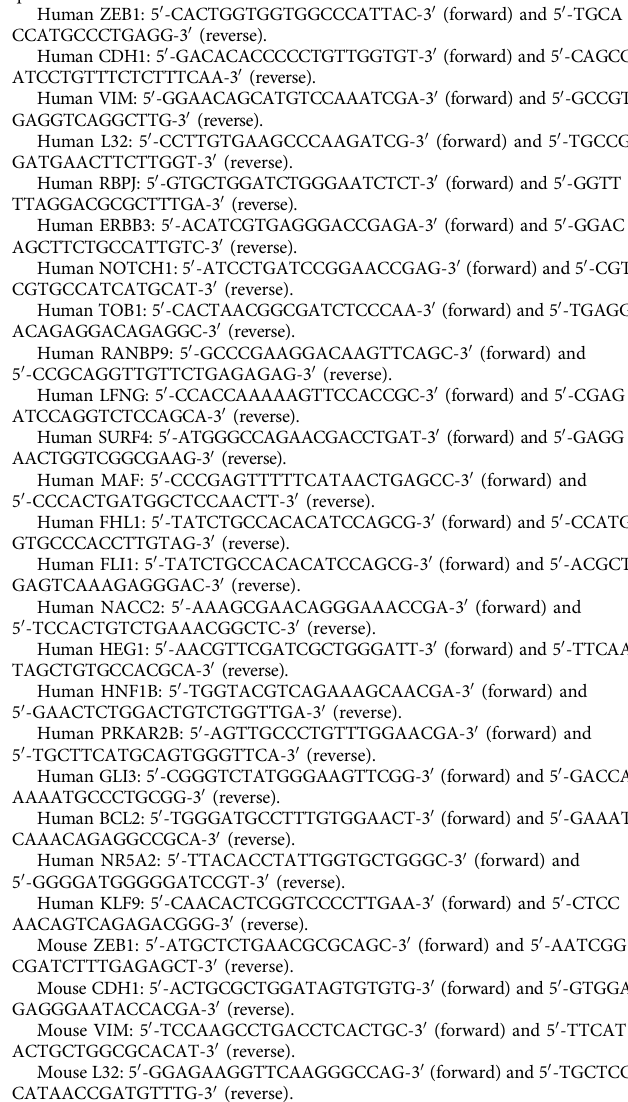
and 5 0 -TTGCGGCCGCGCTGCAAAGAGCACCTTT-3 0 (reverse); miR-200c- binding site mutant LFNG 3 0 -UTR: 5 0 -CTTTTTTTACTGTGCTGTTTTTTTTG-3 0 (forward) and 5 0 -GGTGTCACAATATTTACAGACACG-3 0 (reverse). NOTCH1 3 0 -UTR: 5 0 -GCTCTAGAGCCGACCAGAGGAGCCTTTT-3 0 (forward) and 5 0 -TTGCGGCCGCAACATCTTGGGACGCATCTGG-3 0 (reverse); miR-200c-binding site mutant NOTCH1 3 0 -UTR: 5 0 -CTTATGTAGTTGTTCGT TGGTTATAC-3 0 (forward) and 5 0 -GGTGAACCTGAAACAAAGATTCATG-3 0 (reverse). BCL2 3 0 -UTR: 5 0 -GCTCTAGAGCCACTGAGGAGCTTTGTTT-3 0 (forward) and 5 0 -TTGCGGCCGCGGCCTCTCTTGCGGAGTATT-3 0 (reverse). FHL 3 0 -UTR: 5 0 -GCTCTAGAATCTGGCCAACAAGCGCTTT-3 0 (forward) and 5 0 -TTGCGGCCGCGCAGGTTATTCATATGCTGC-3 0 (reverse).